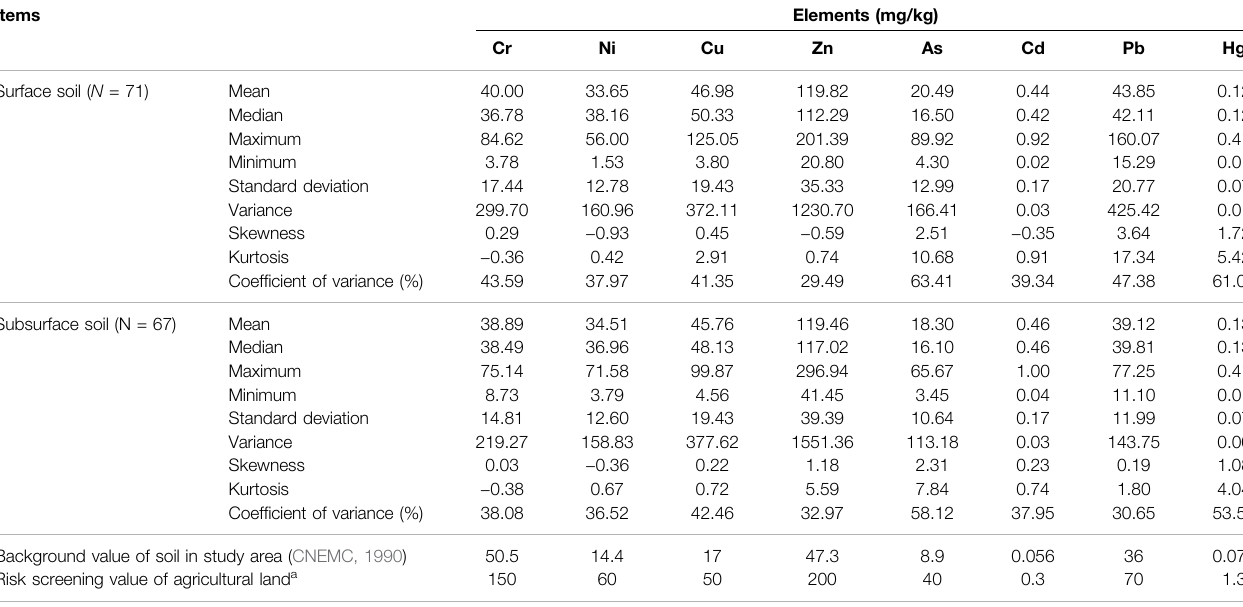
TABLE 1 | Summary of statistical result characteristics of heavy metals in surface and subsurface soil in the study area. Items